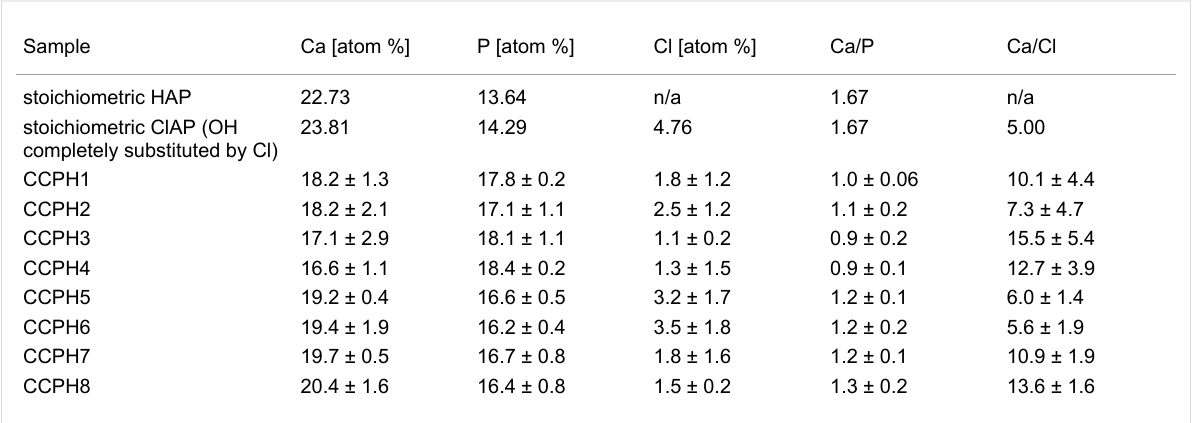
Table 4: EDXS data of the CCPH materials.